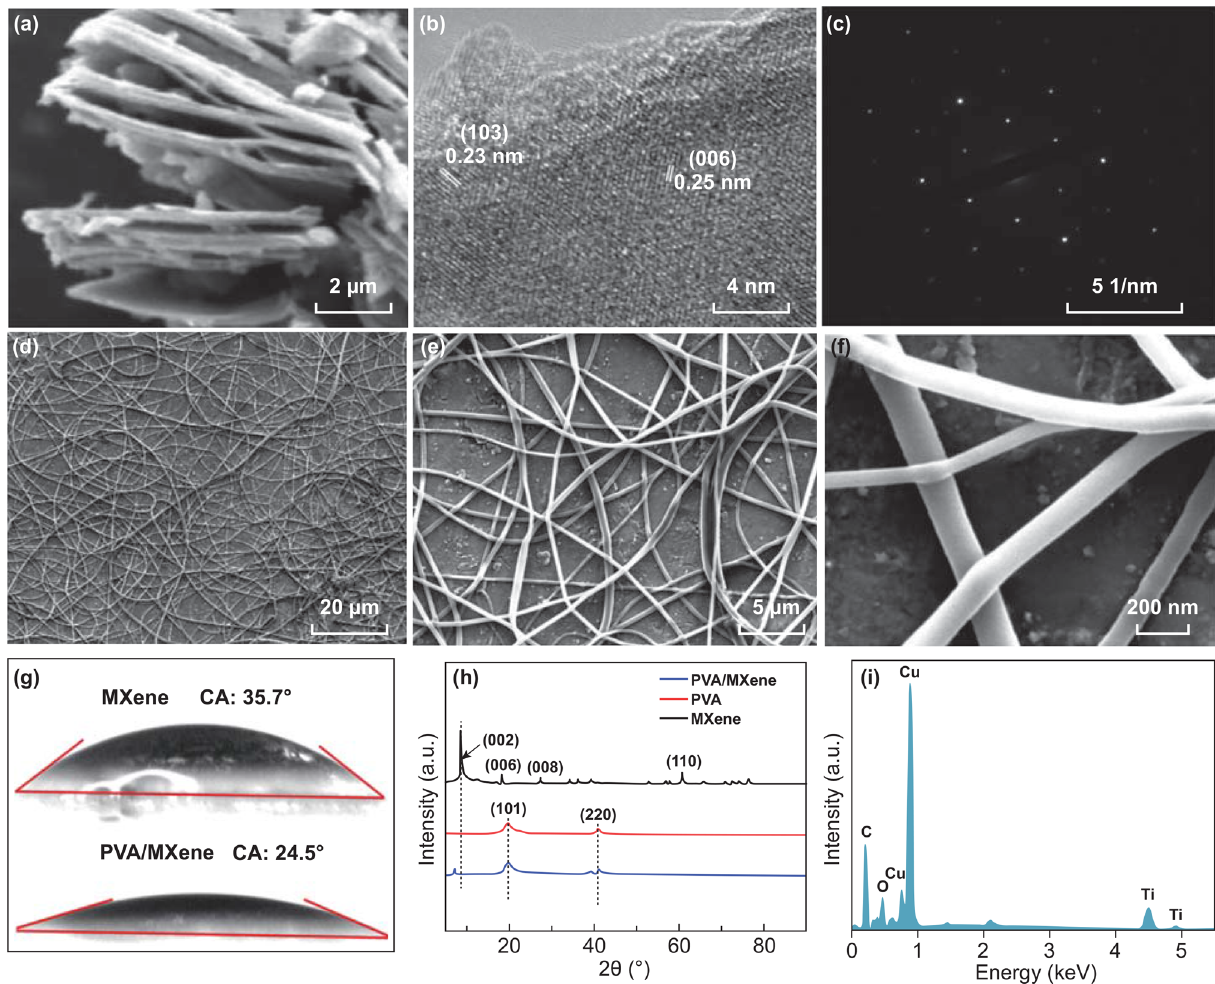
Fig. 4 a SEM of MXene multilayer structure. b TEM images of few-layer MXene nanoflakes. c Corresponding selected-area electron diffraction (SAED) pattern of the hexagonal arrangement of atoms. d, e SEM images of PVA/MXene nanofibers. f Contact angle measurement of MXene and PVA/MXene. g XRD, h EDS, and i FTIR pattern of MXene, PVA, and PVA/MXene